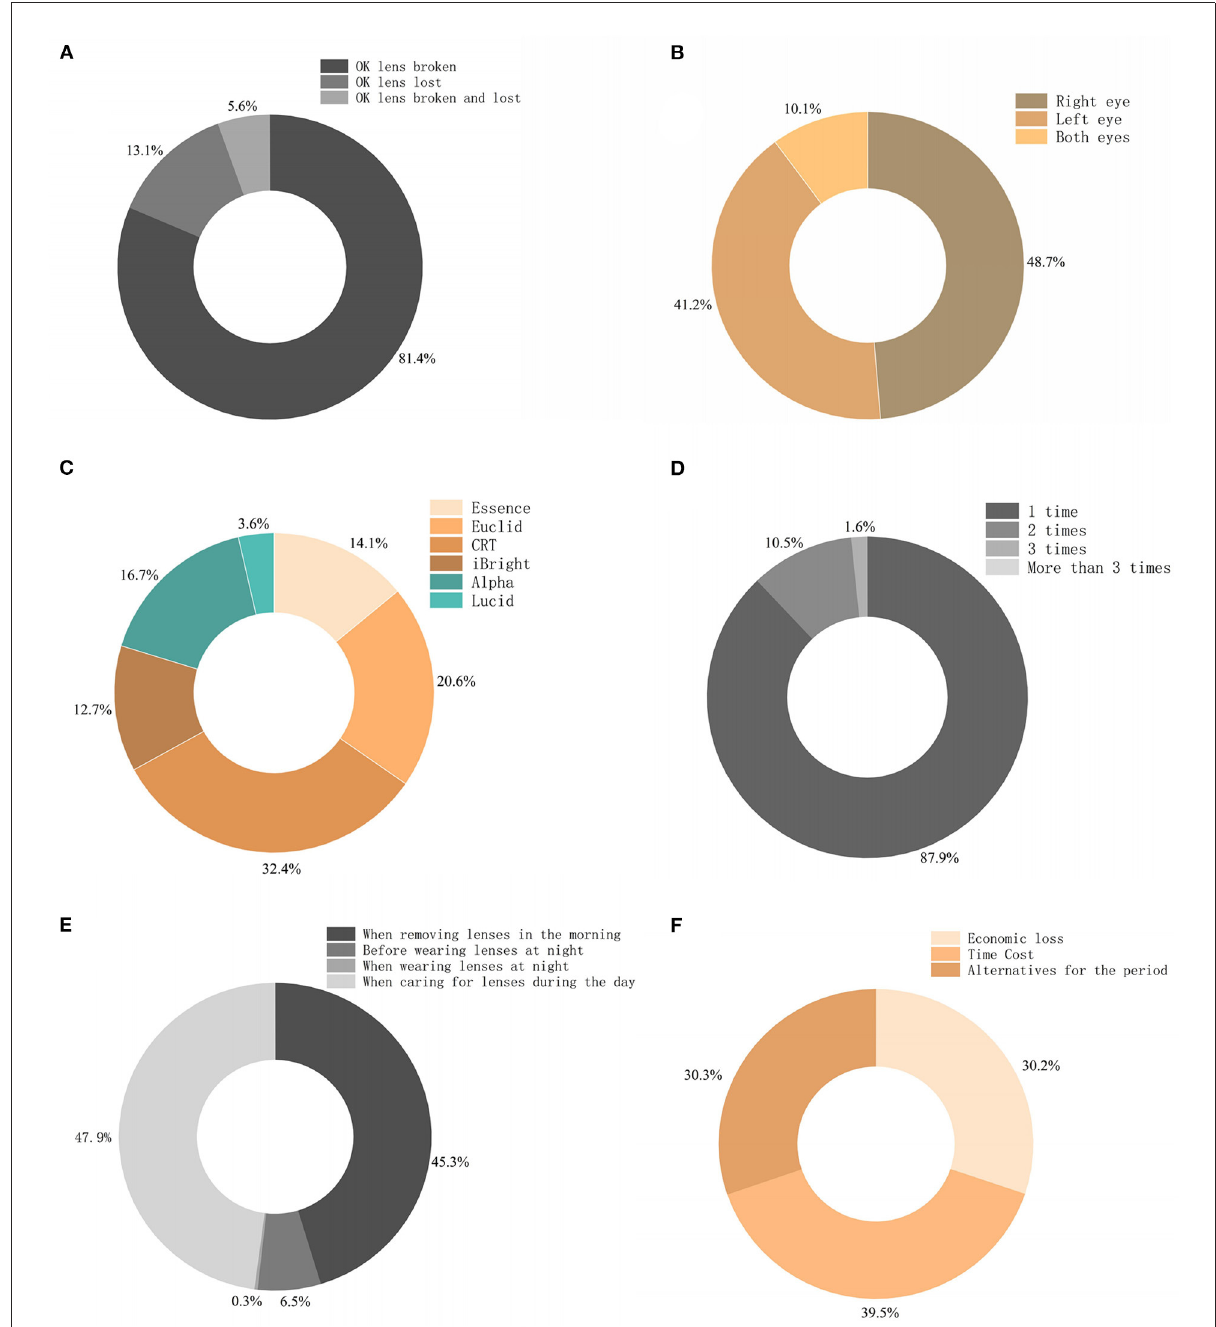
FIGURE1 Basic survey information. (A) Classification of abnormal OK waste. (B) Eye affected by the loss of the OK lens. (C) Brand of lenses with waste. (D) Frequency of OK lens waste in a year. (E) Time when the waste of the OK lens occurred. (F) Largest concern/problem imposed by OK lens waste.